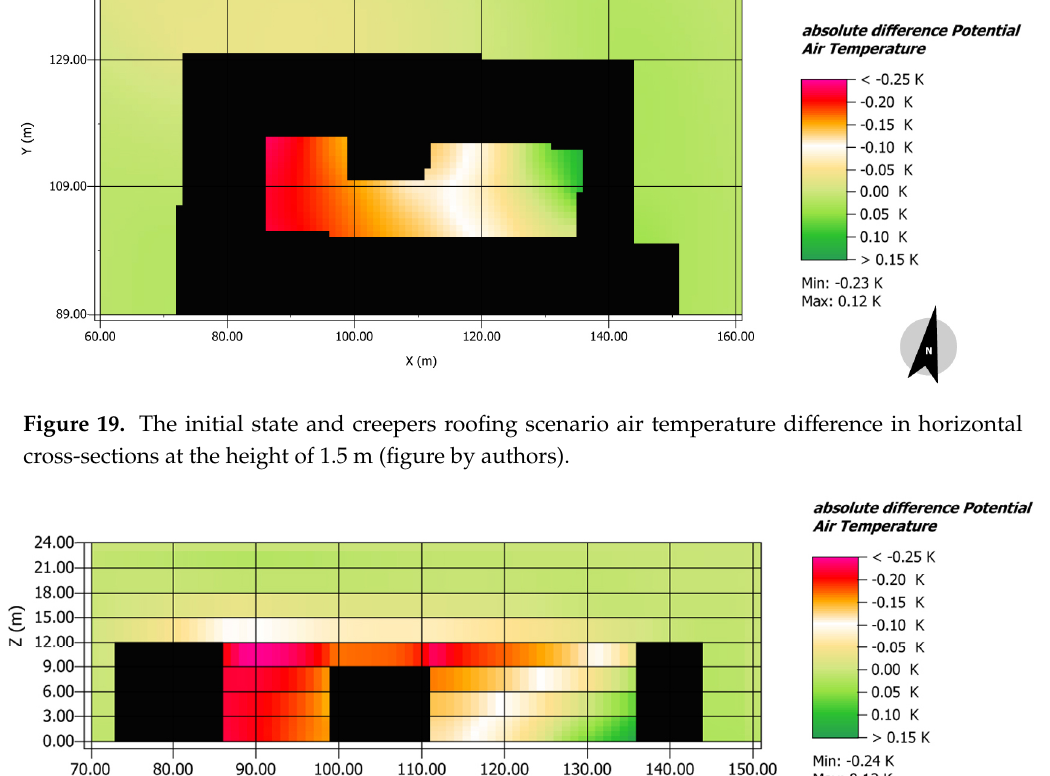
Figure 20. The initial state and creepers roofing scenario air temperature difference in vertical cross section on the east–west axis from the north side view. Figure by authors.